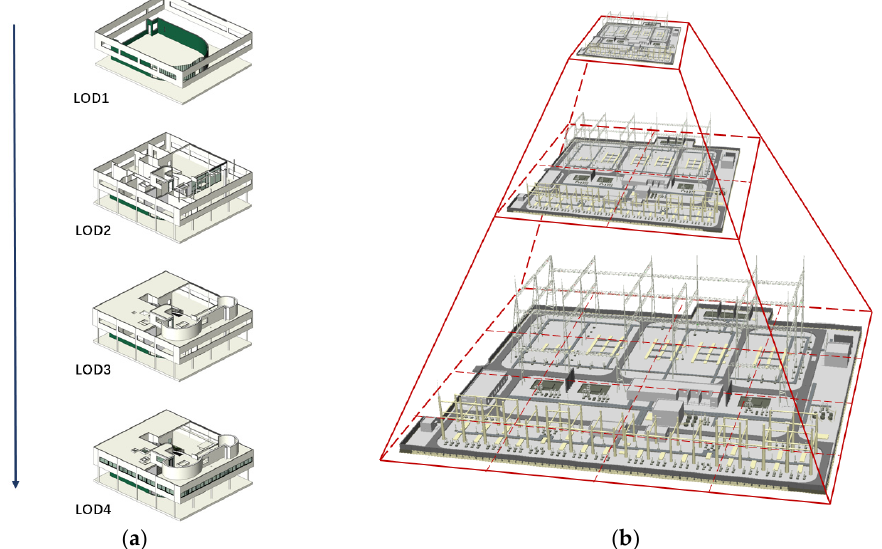
Figure 2. Data organization for BIM: ( a ) semantics-based data organization, and ( b ) quadtree data organization.